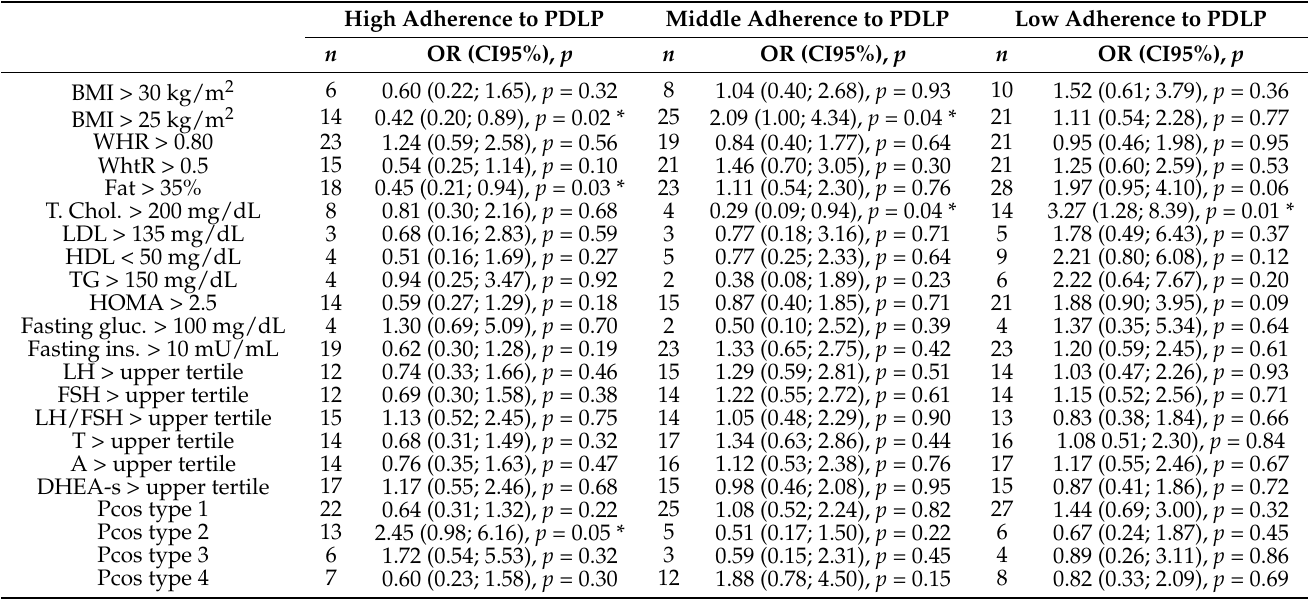
Table 3. The adherence to the prudent dietary-lifestyle pattern (PDLP) and it’s relation with different metabolic and endocrine markers.